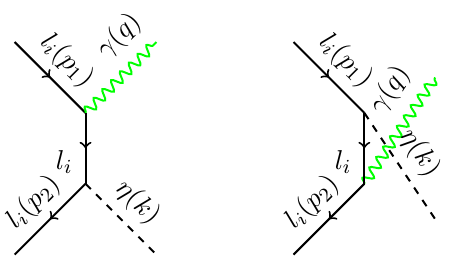
Figure 10 . Diagrams (c) and (d) contributing to the l i l i ! (cid:17)(cid:13)